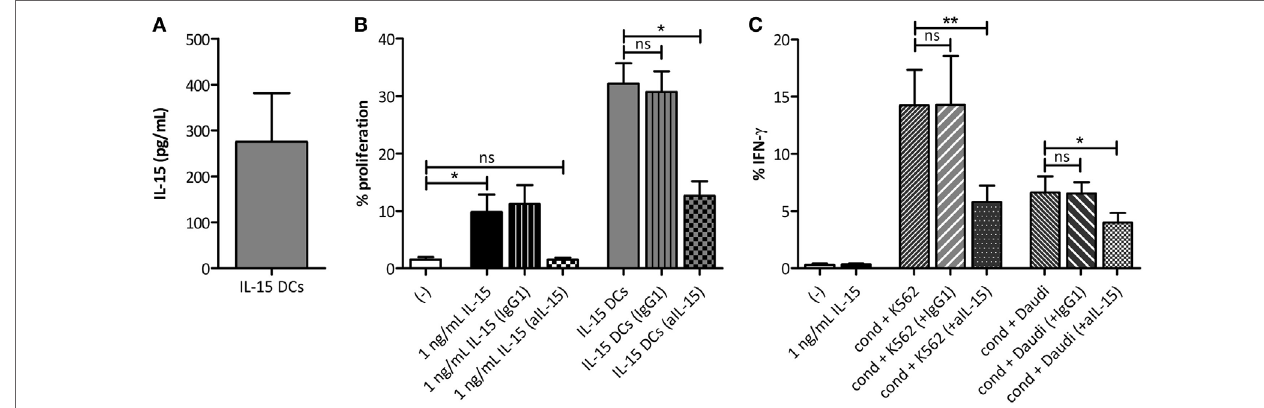
FigUre 3 | IL-15, secreted by IL-15 dendritic cells (DCs), provides an important signal for DC-mediated γδ T cell proliferation and IFN- γ production. (a) Representation of the IL-15 secretion level (pg/mL), as determined by Meso Scale Discovery immunoassay, in 48-hour wash-out supernatant of IL-15 DC cultures (1 × 10 6 cells/mL; n = 3). (B) CFSE-labeled peripheral blood mononuclear cells (PBMCs) were co-cultured with 1 ng/mL recombinant IL-15 or IL-15 DCs (E:T ratio = 1:10). In certain conditions, neutralizing IL-15 monoclonal antibodies (mAbs) (aIL-15) or isotype control mAbs (IgG1) were added to the IL-15 DC cultures 1 hour prior to the addition of PBMCs. Percentages refer to the proportion of γδ T cells that proliferated within 5 days ( n = 6). Friedman test with Dunn’s Multiple Comparison Test. (c) After overnight culture of γδ T cells in full PBMC fraction with IL-15 DCs + IPP ( = cond) and K562 or Daudi tumor cells (E:T ratio = 1:10), with anti-IL-15 mAbs (aIL-15) or with isotype control mAbs (IgG1), intracellular IFN- γ production was measured with flow cytometry in γδ T cells ( n = 6). Friedman test with Dunn’s Multiple Comparison Test. ** p < 0.01 and * p < 0.5; ns, p >